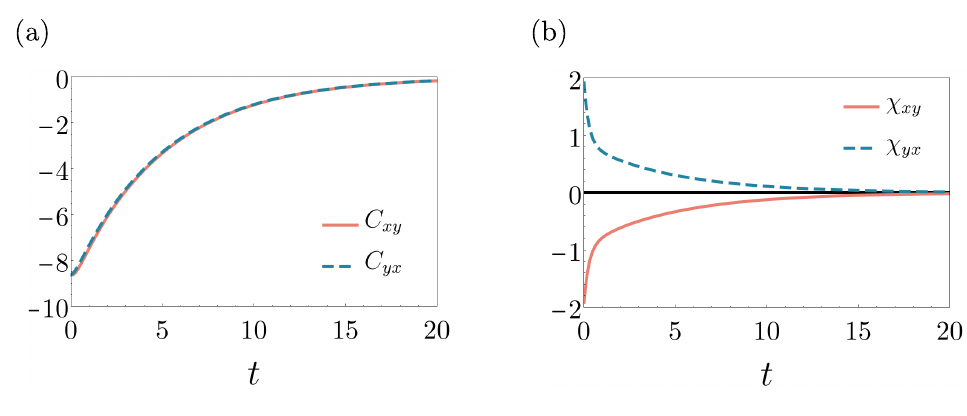
Figure 3: Cross-correlation and -response functions at criticality ( J = 1, ∆ = 1, Γ = 4, N = 100). A modified form of TRS emerges at critical- ity where correlation (panel a) and response (panel b) functions exhibit opposite parities under time-reversal transformation.